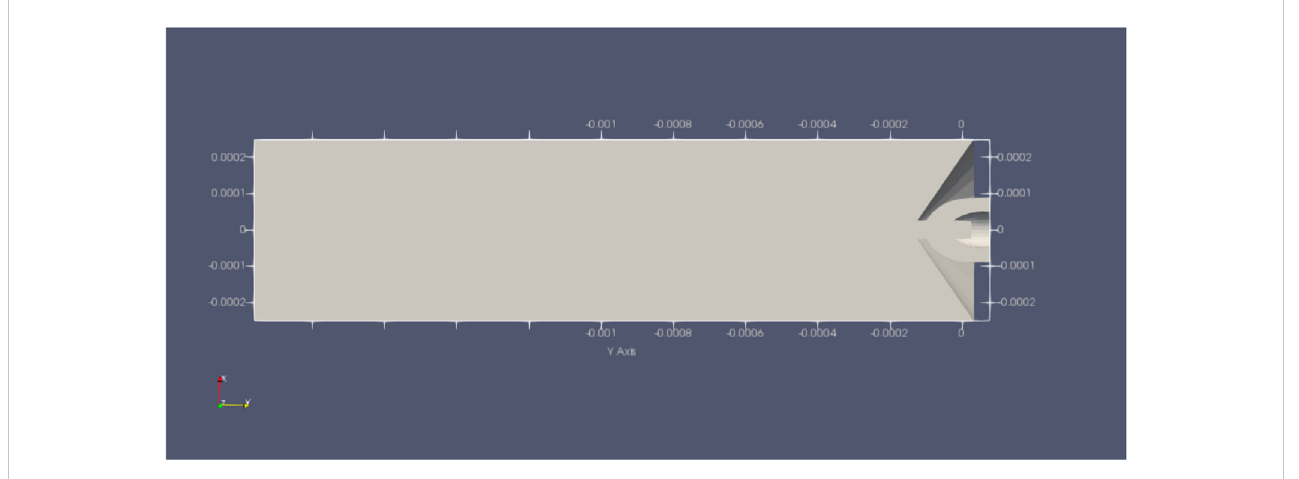
FIGURE 7 Complete fl ow fi eld region for the bell-shaped nozzle numerical